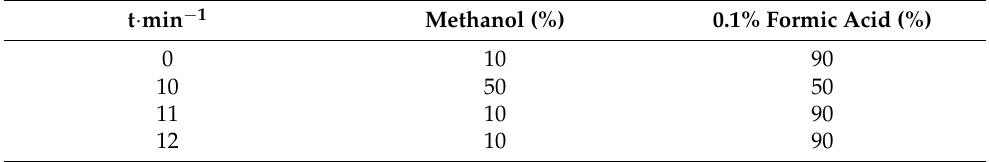
Table 1. Gradient elution